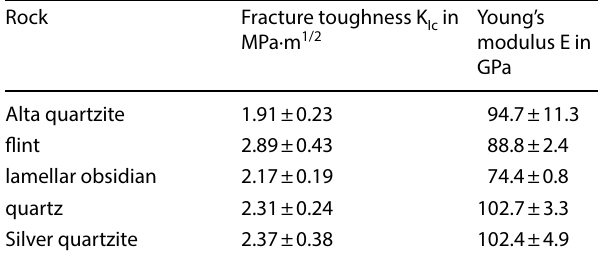
Table 3 Fracture toughness and Young’s modulus of the rocks at 25 °C